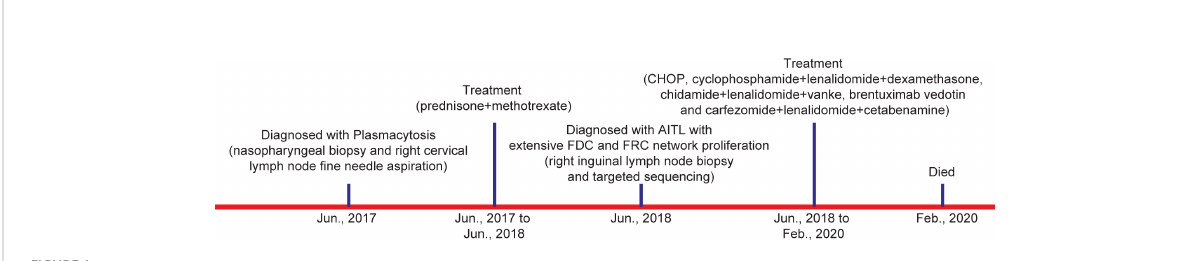
FIGURE 1 Diagnosis and treatment process of the patient. (AITL, angioimmunoblastic T-cell lymphoma; FDC, follicular dendritic cell; FRC, fi broblastic reticular